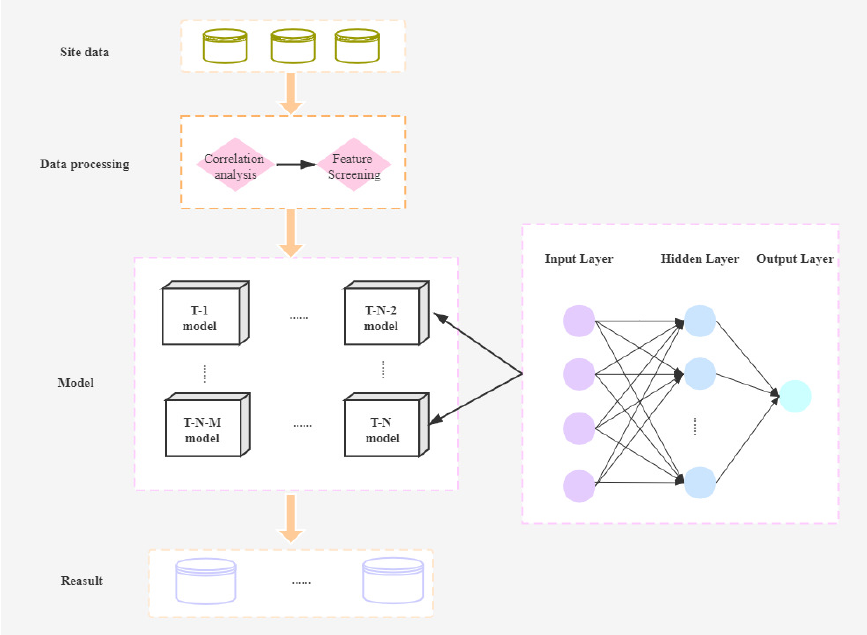
Figure 4. In the figure, T means forecast T hours in advance, and M and N both represent the size of time windows. When the time window is N, the number of BP neural network models is N. Among them, 0 < M < N, T-N-M >